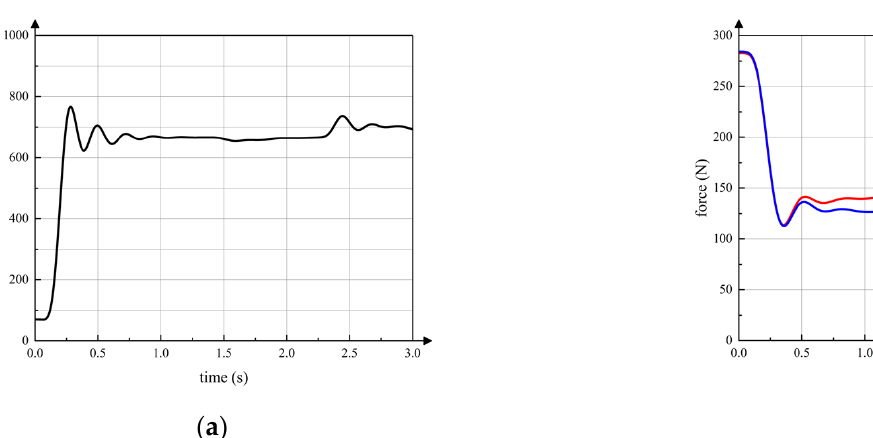
Figure 18. Simulation of wheeled motion (unilateral passive wheels and active wheel on slope). ( a ) no wheel on slope; ( b ) front wheel on slope; ( c ) front wheel and active wheel on slope; ( d ) Three wheels on slope.